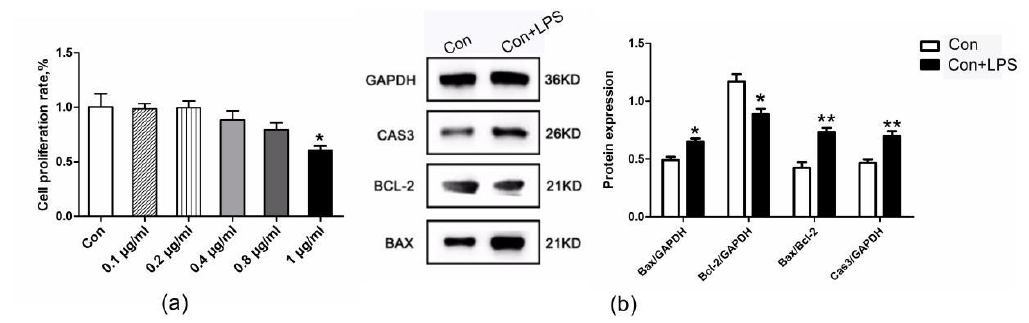
Figure 2. Lipopolysaccharide (LPS) treatment leads to increased apoptosis of ovarian granulosa cells. ( a ) Cell Counting Kit-8 (CCK-8) used to determine the effects of LPS on the cytotoxicity to GCs cells. ( b ) E ff ect of LPS (1 µ g / mL) on the protein expression of BAX, BCL-2, and CAS3 in bGCs. Data are presented as the means ± thestandarderrors of the mean (SEM). ∗ p < 0.05; ∗∗ p < 0.01.